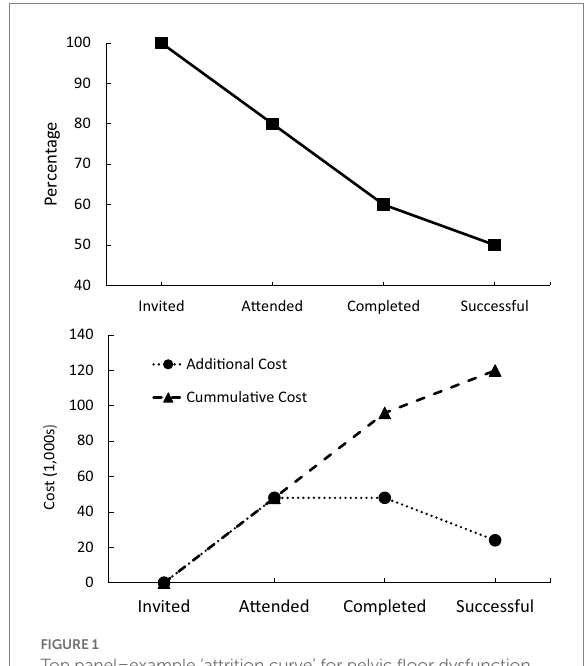
FIGURE 1 Top panel = example ‘attrition curve’ for pelvic floor dysfunction patients undergoing physiotherapy. Bottom panel = costs of surgical and other procedures per patient in United